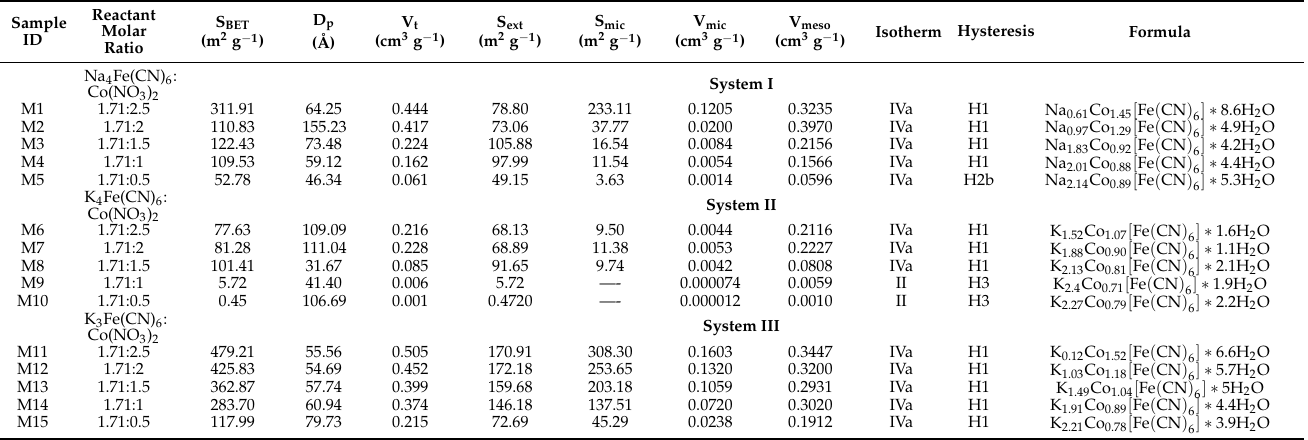
Table 1. Textural properties of CoHCFs samples obtained from N 2 adsorption measurements and stoichiometric coefficients for each